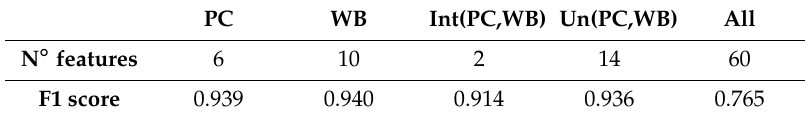
Table 5. Comparison of di ff erent feature selection methods for slippage classification.